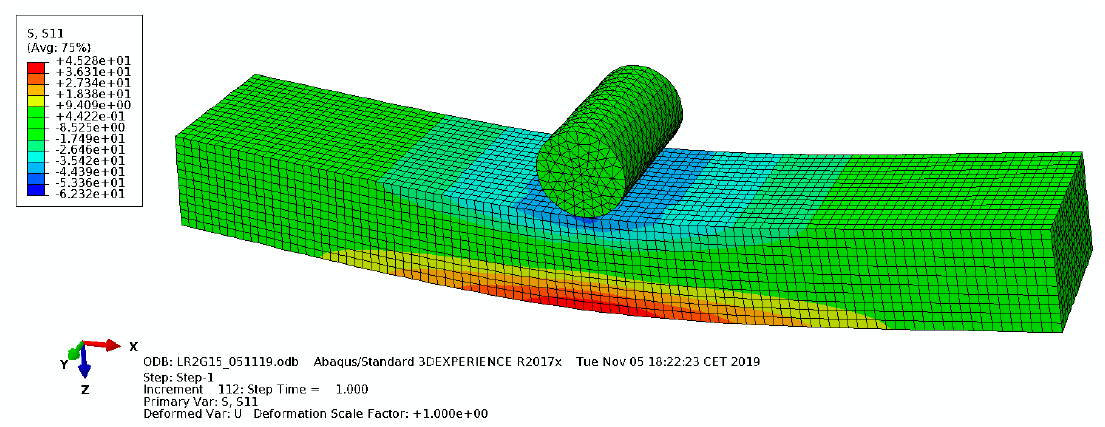
Figure 5. Stress field obtained from the finite element method (FEM) analysis for LR2G1.5.